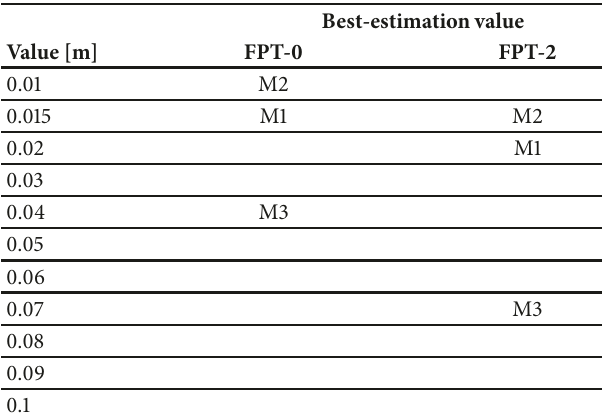
Table 5: Characteristiclength values investigated for the FPT-0 and FPT-2